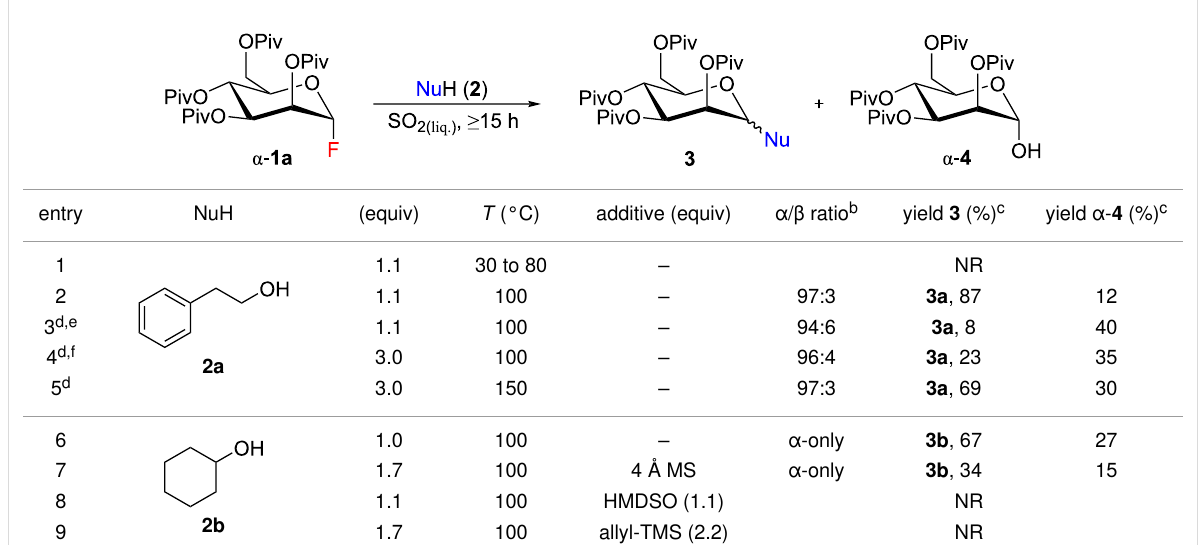
Table 1: Screening of conditions for glycosylation in liquid SO 2 .